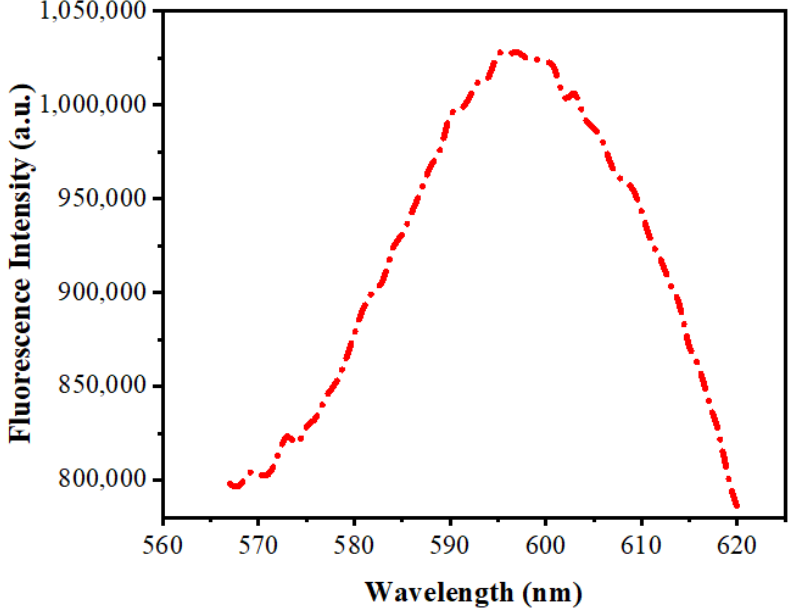
Figure 6. Fluorescence spectra of Mn:ZnS QDs.